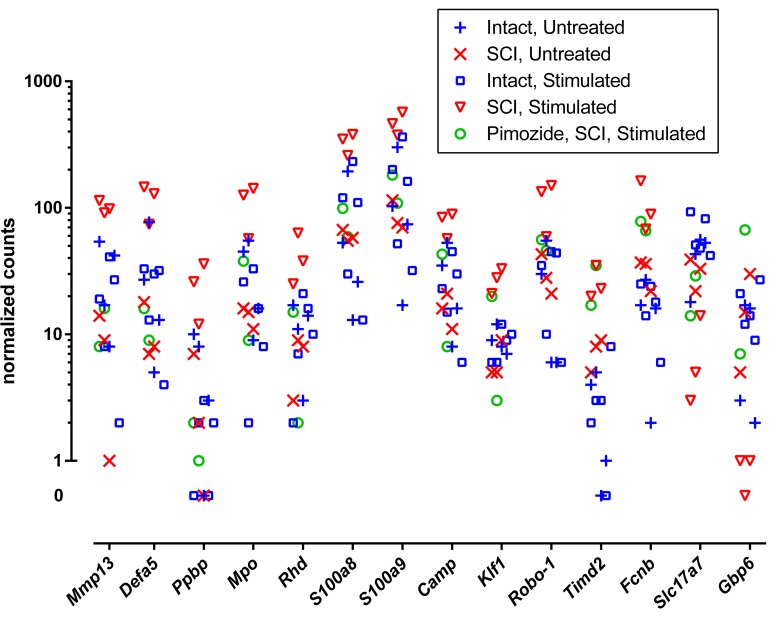
Normalized RNA molecular counts from individual rats for 14 characterized genes identified as prominently up-regulated (n = 12) or down-regulated (n = 2) by stimulation. The included genes were those flagged by all three contrasts ±st(SCI), ±SCI(st) and ±st/SCI(0), as listed in Table 2. The vertical axis is scaled logarithmically and log zero values (equal to –∞) are presented separately off-scale.